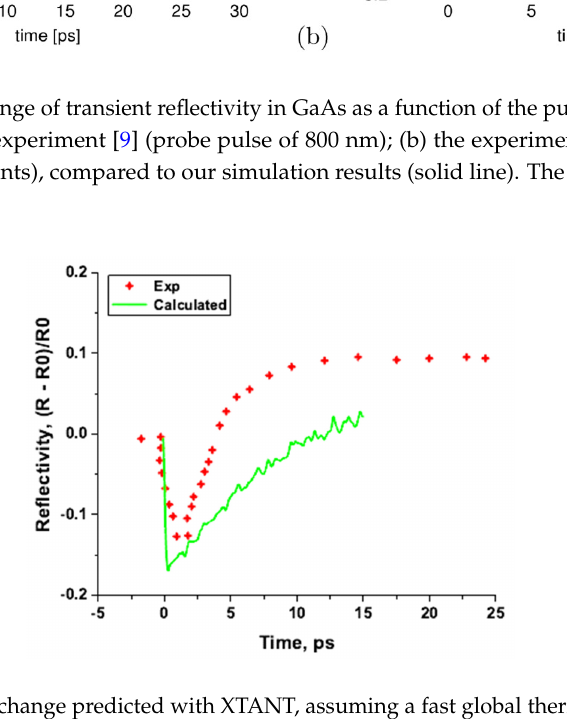
Figure 11. Reflectivity change predicted with XTANT, assuming a fast global thermalization of carriers between valence and conduction bands at 800 eV free-electron-lasers (FEL) pump photon energy and 40 mJ/cm 2 pulse